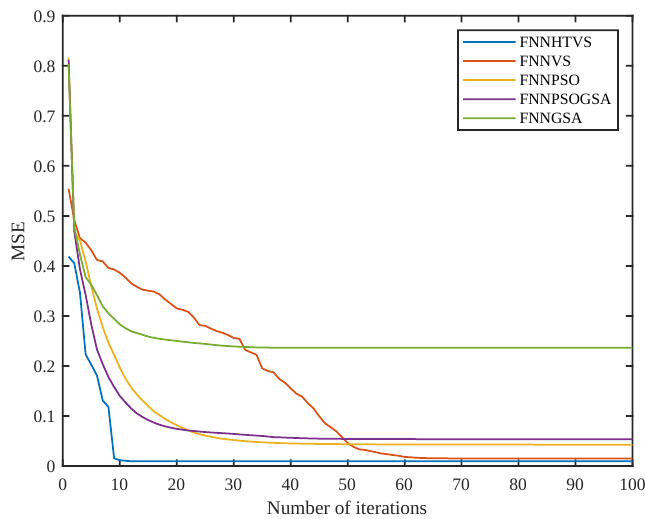
Figure 5. Box plot chart for fault classification.